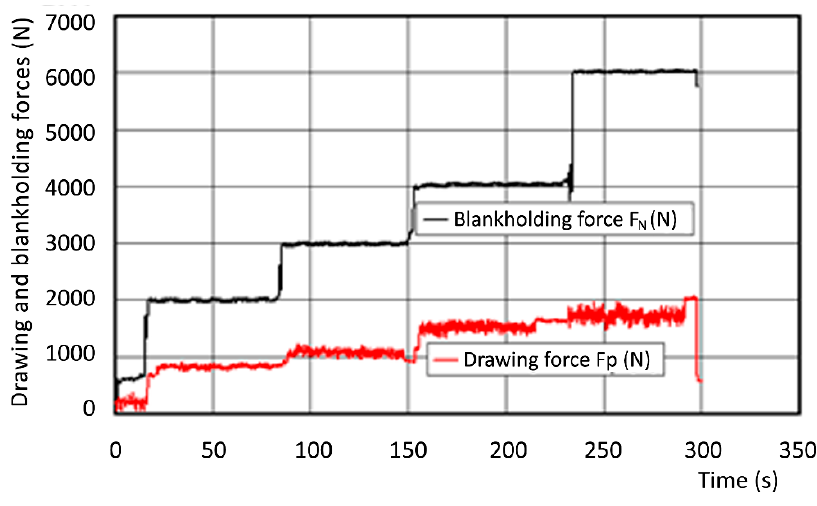
Figure 4. Record of the drawing and blankholding forces in the strip drawing test.